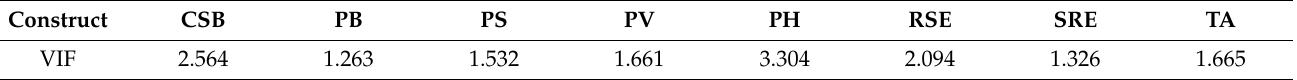
Table 2. Full Collinearity.